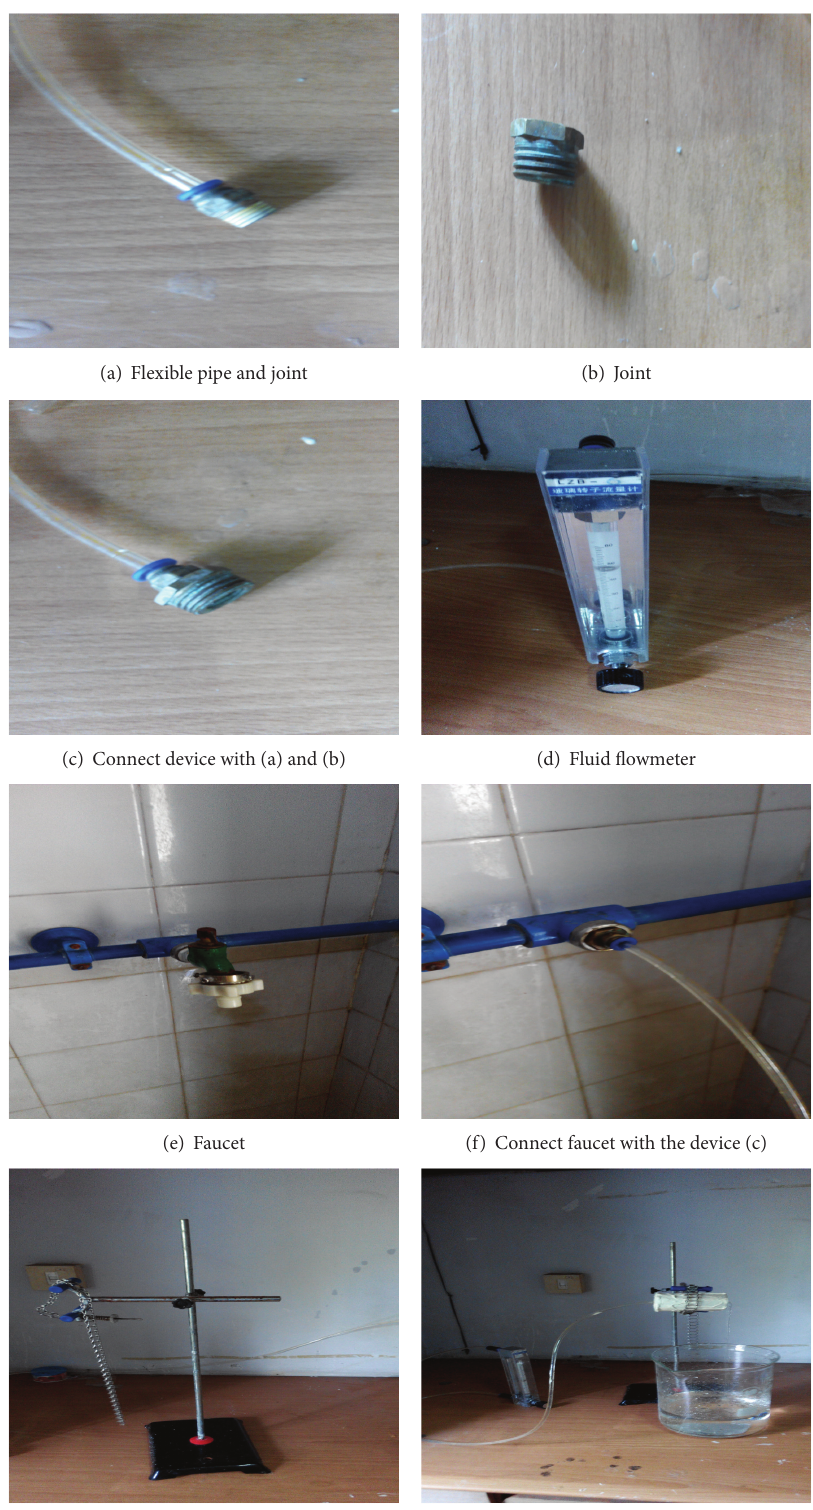
Figure 2: Device for dynamic dissolving test for rock